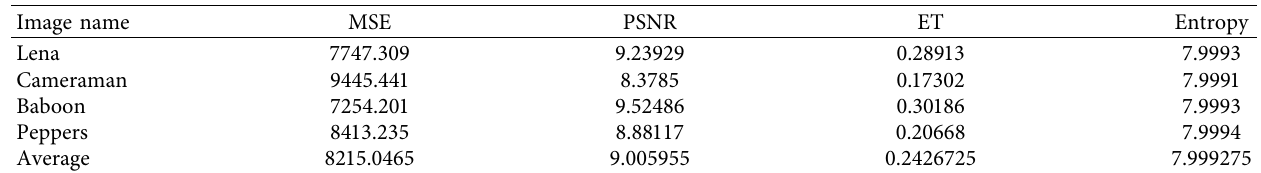
Figure 15: Key sensitivity of encrypted process: (a) Cameraman plain image; (b) Cameraman encrypted image with first key; and (c) Cameraman encrypted image with another key. Table 2: Parameters of the encryption quality for different test image. Please note that MSE, PSNR (dB), and ET (sec) stand for minimum mean square error, peak signal-to-noise ratio, and elapsed time,